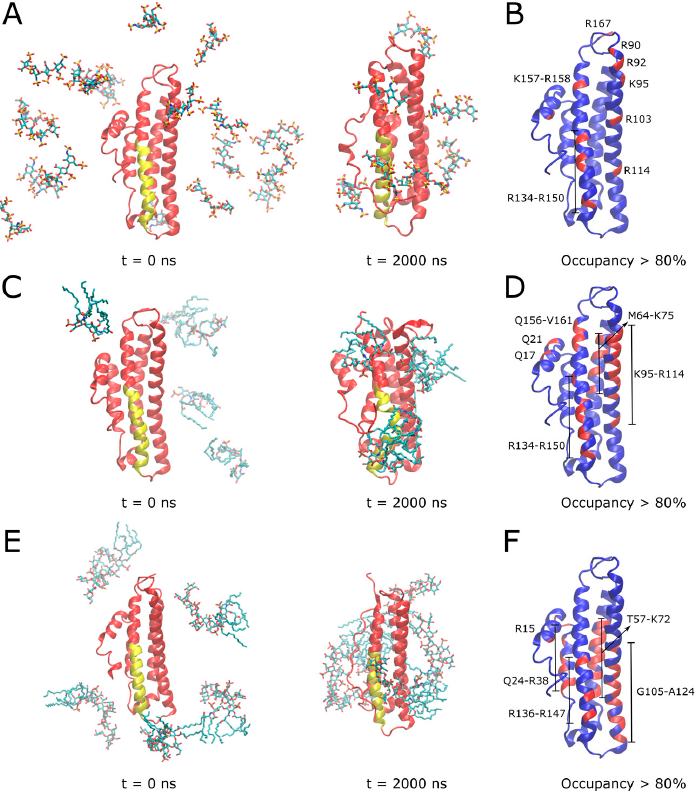
Figure 6. MD simulations to investigate binding modes of heparin, lipid A and LPS with APOE. In ( A , C , E ), initial and final simulation snapshots of systems containing truncated APOE with heparin, lipid A, and full LPS molecules are shown, respectively. In ( B , D , F ), APOE is shown in blue with a per- residue ligand occupancy (<0.3 nm cutoff distance) for >80% of total simulation sampling highlighted in red, for heparin, lipid A, and LPS systems, respectively. In ( A , C , E ), N-terminal domain is colored in red with receptor binding region on helix 4 colored in yellow. Ligand molecules are shown in CPK sticks representation (cyan—carbon; red—oxygen; blue—nitrogen; brown—phosphorus; sulfur—yellow). Simulation time points are indicated below snapshots, reported in nanoseconds